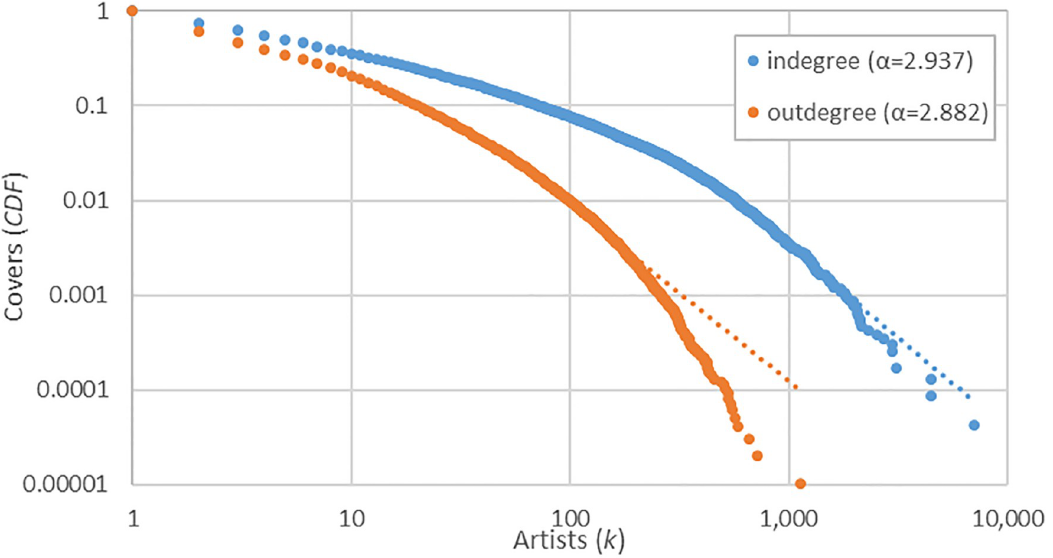
Fig 1. Cumulative distribution function (CDF) of the number of received (indegree) and performed (outdegree) covers by artist (log-log), and their respective exponents ( α ).